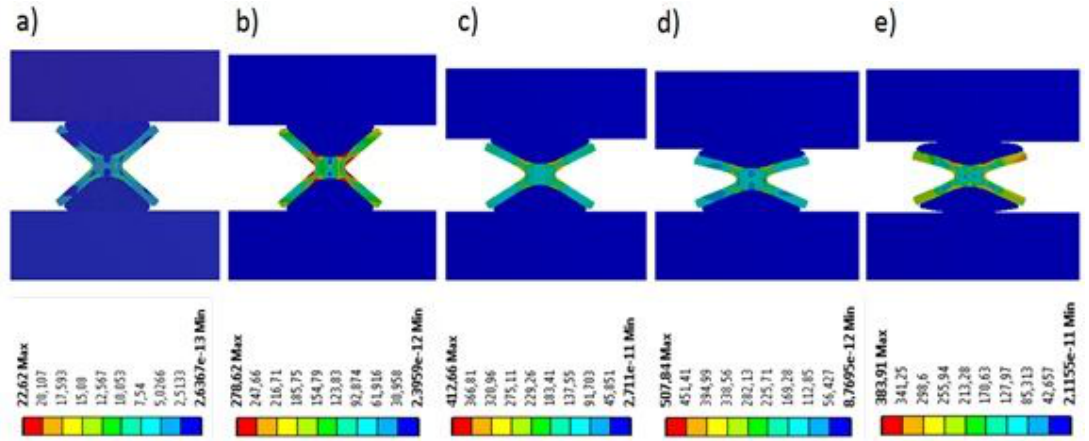
Figure 9: Equivalent stress distribution in MPa of gasket model No. 110: a) compression 0.3 mm, b) compression 0.5 mm, c) compression 1.5 mm, d) compression 3 mm, e) decompression 1.5